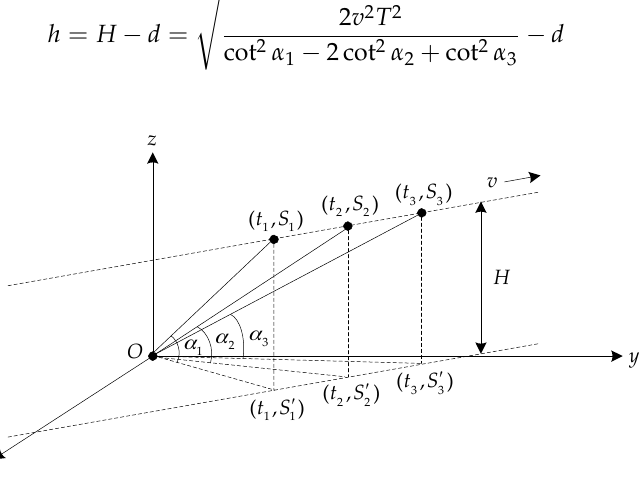
Figure 9. The motion track of the target moving on a straight line at the constant height and at the constant velocity.